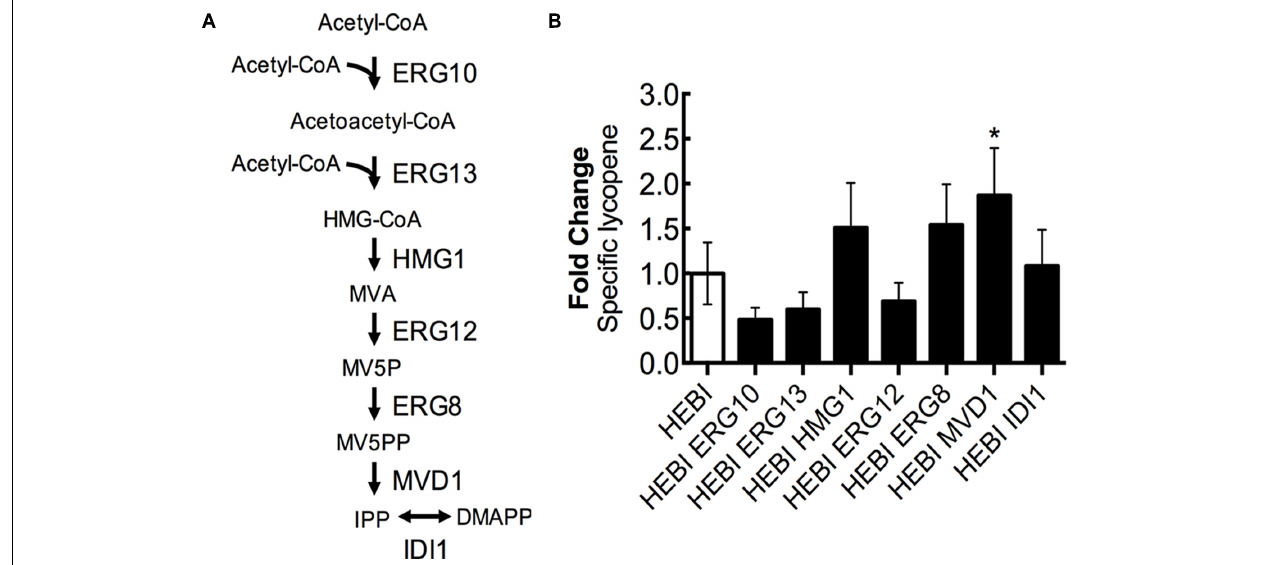
FIGURE 6 | Engineering mevalonate biosynthesis pathway. (A) Schematic representation of the mevalonate pathway. (B) Relative specific lycopene production from strains with a single gene in the mevalonate pathway overexpressed. Strains were grown for 4 days in 25 mL of YPD10 at 30 ◦ C in baffled shake flasks. Bars and error bars represent the mean and standard deviation, respectively, of biological triplicates. Statistical significance from the HEBI strain is indicated by “ ∗ ”. The HEBI strain produced 3.2 ± 0.9 mg lycopene/g DCW.